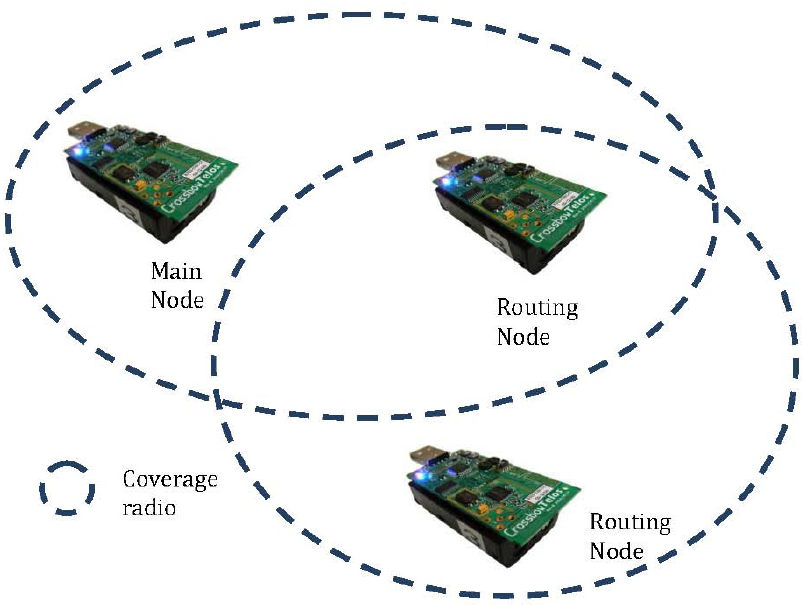
Figure 10. Node distribution and coverage in the